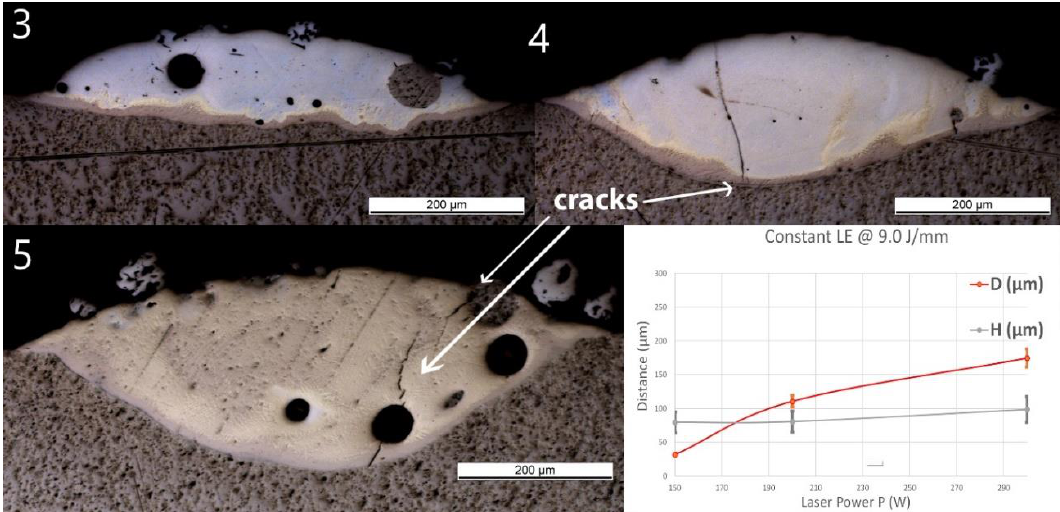
Figure 6. OM images of cross-sections of samples Line_LE_3 to Line_LE_5. The last diagram (bottom right) shows the influence of power (P) (together with proportionally increased speed S, maintaining a constant laser energy of LE = 9.0 J/mm) on penetration depth (D) and deposition height (H) of the tracks.